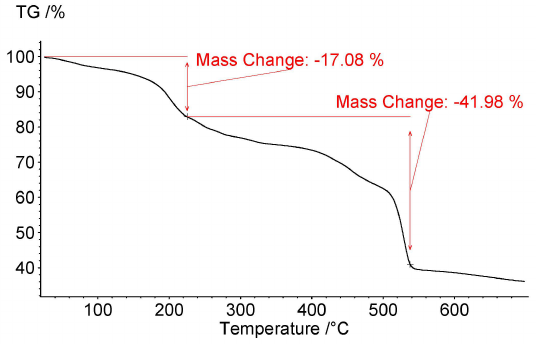
Figure 5. TGA of 2 in the temperature range 20–700 ˝